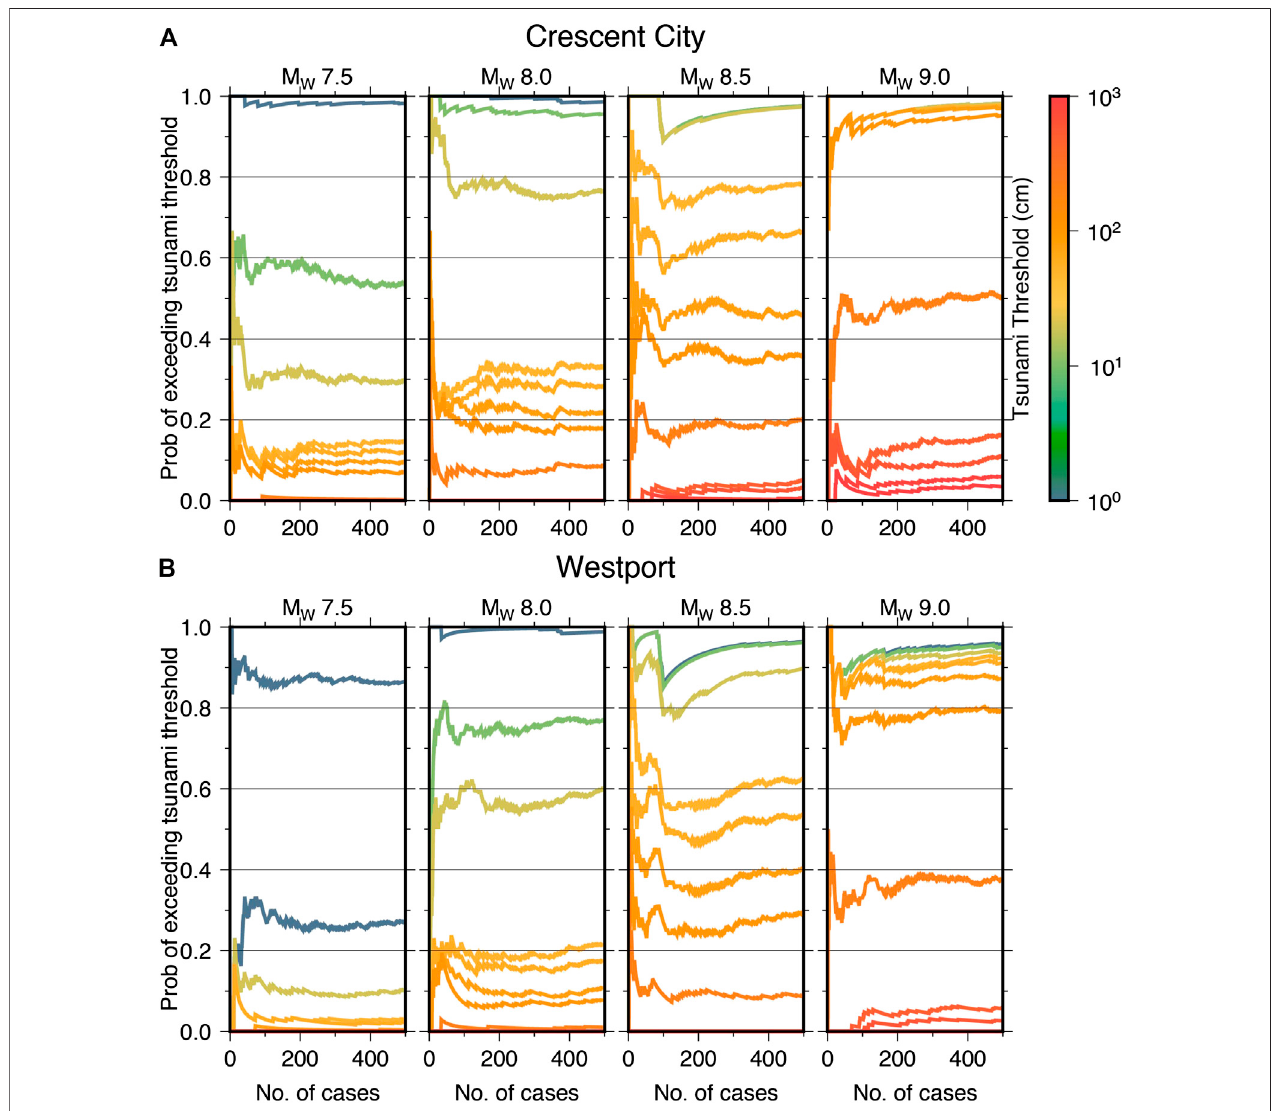
FIGURE4| Theprobabilityofexceedingaspeci fi edtsunamithresholdasafunctionofthenumberofcasesincludedforeachmagnitudeclassatparticularpointsin (A) Crescent City and (B) Westport. Thresholds tested range from 1 cm to 10 m, with a separate curve for each, color-coded as indicated by the color bar.